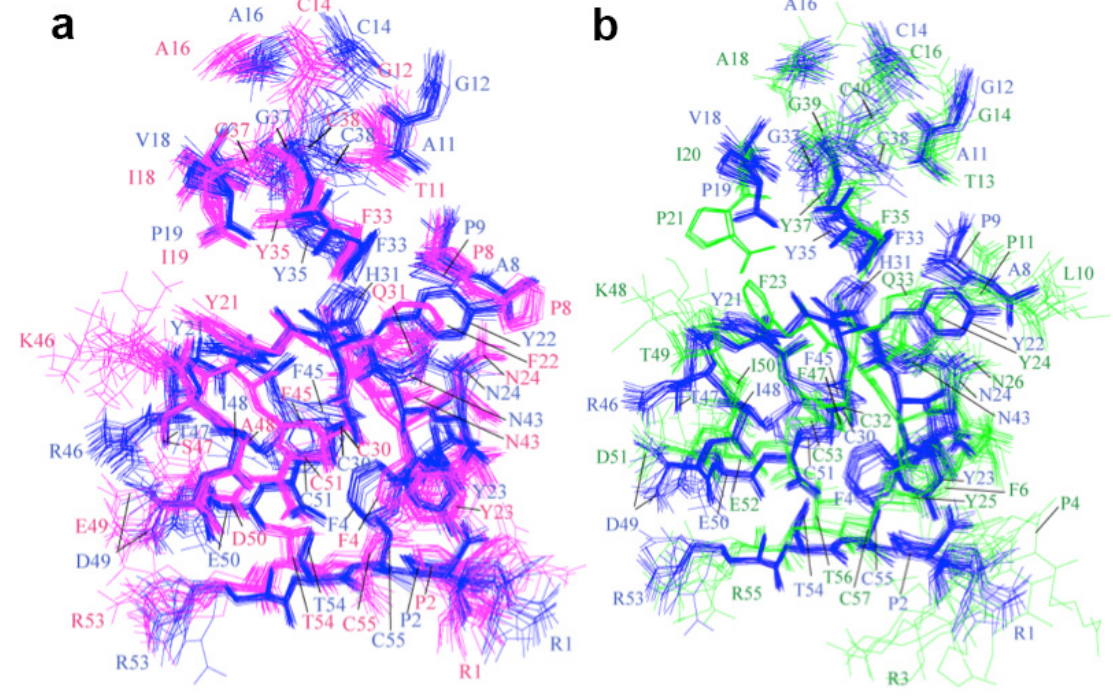
Figure 4. Comparison of residue-residue interactions between ( a ) NACI (blue) and BPTI (magenta) and ( b ) NACI (blue) and BF9 (green). Residues 1, 2, 4, 5, 8, 9, 11, 12, 14, 16, 18, 19, 21, 22, 23, 24, 30, 31, 33, 35, 37, 38, 43, 45, 46, 47, 48, 49, 50, 51, 53, 54, and